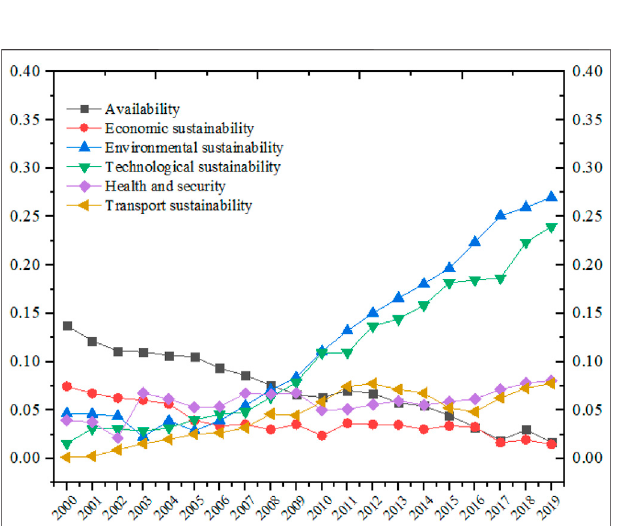
FIGURE 9 | Transport sustainability results from 2000 to 2019: (A) indicator value; (B) dimension value.